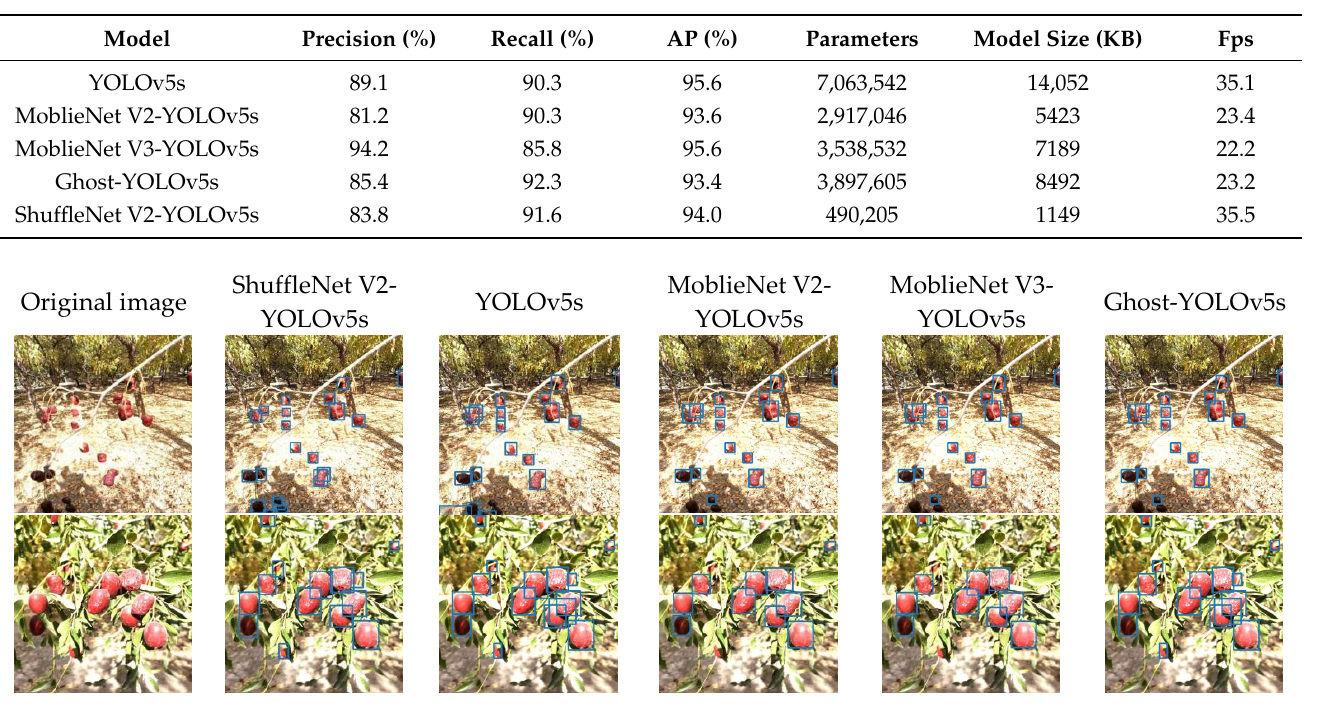
( f ) Figure 11. the results of different algorithms for the recognition of red jujube. ( a ) the original image of a dense jujube sample. ( b ) the original model to dense jujube detection image. ( c ) the improved model to dense jujube detection image. ( d ) the original image of leaf-obscured jujube. ( e ) the original model to leaf-obscured jujube detection image. ( f ) the improved model to leaf-obscured jujube de- tection image. Where the red boxes are the label boxes marked manually, and the blue boxes are the test results of model test. 3.2. Performance Comparison Using the Different Lightweight Backbone Networks In order to embed mobile devices, the ShuffleNet V2 backbone network was used in YOLOv5s in this research. MoblieNet V3, as the improved version of MoblieNet V1 and MoblieNet V2, has a large improvement in detection efficiency. In order to verify the de- tection performance of the improved model, the MoblieNet V3 network was used as the backbone of YOLOv5s to compare the improved YOLOv5s, which used the ShuffleNet V2 backbone network and YOLOv5s. The results show that after adding MoblieNet V3 as the backbone, the network has a large improvement in Precision, but a large decrease in Re- call, resulting in the improved YOLOv5s, which is used the MoblieNet V3 backbone net- work and the original YOLOv5s in the same AP, as shown in Table 4. In addition, there is a phenomenon of missing the detection of jujube fruit, as shown in Figure 12. The im-